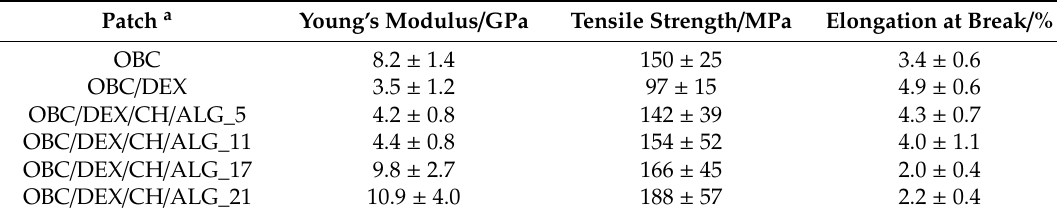
Table 2. Young’s modulus, tensile strength, and elongation at break of the OBC, OBC / DEX, and the multi-layered